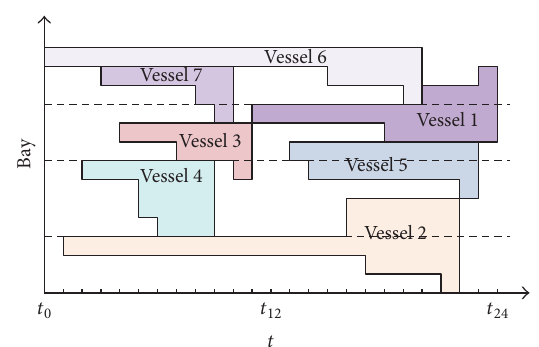
Figure 7: The piling state of containers belonging to 7 vessels using the presented method.